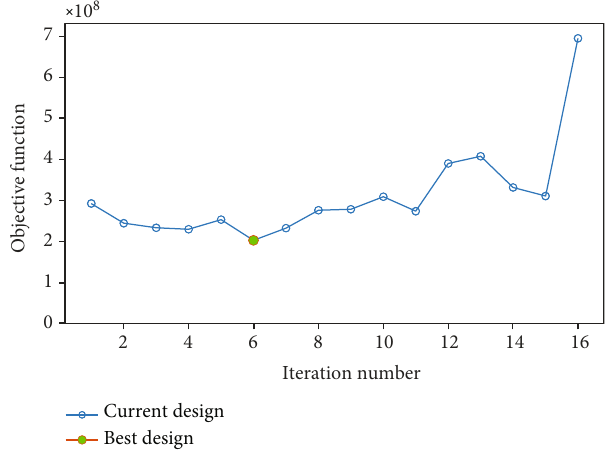
Figure 11: Thickness distribution of the designed tube.